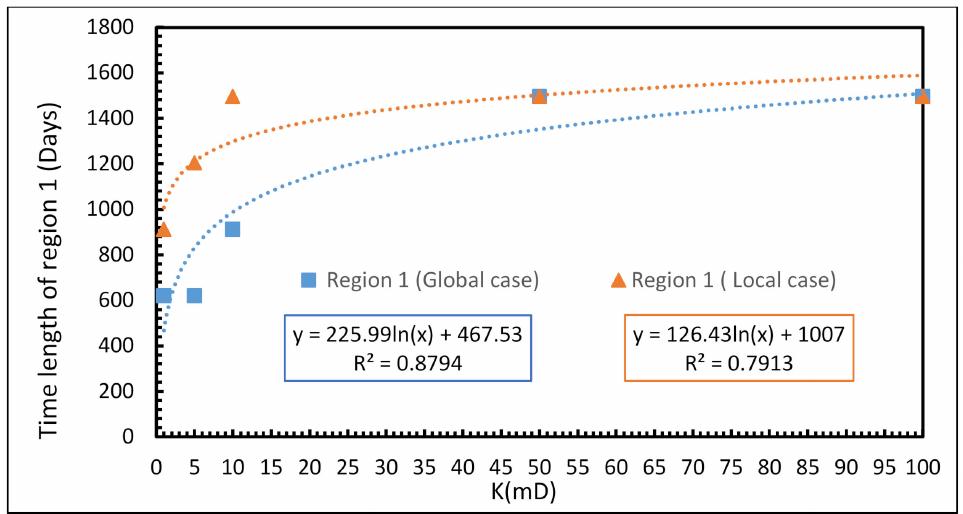
Figure 6. Duration of region 1 for di ff erent cases of permeability at the wellbore for both